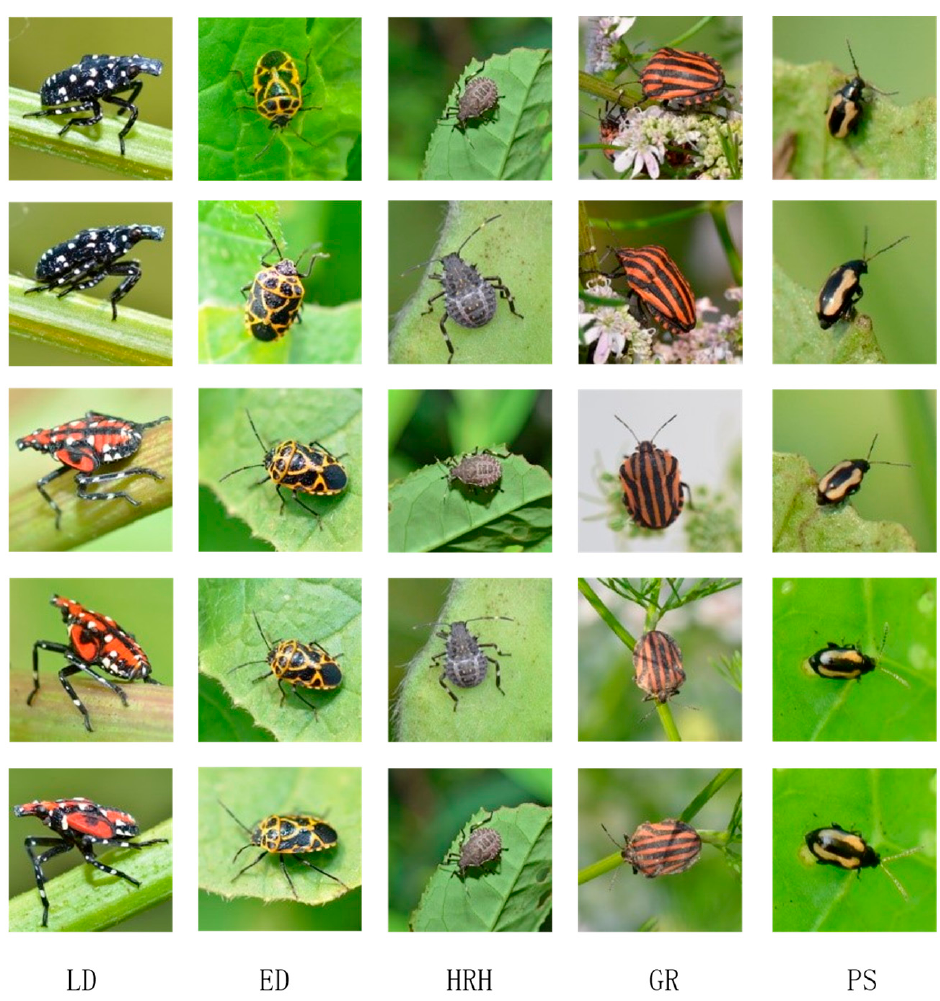
Figure 5. Example images in D0.